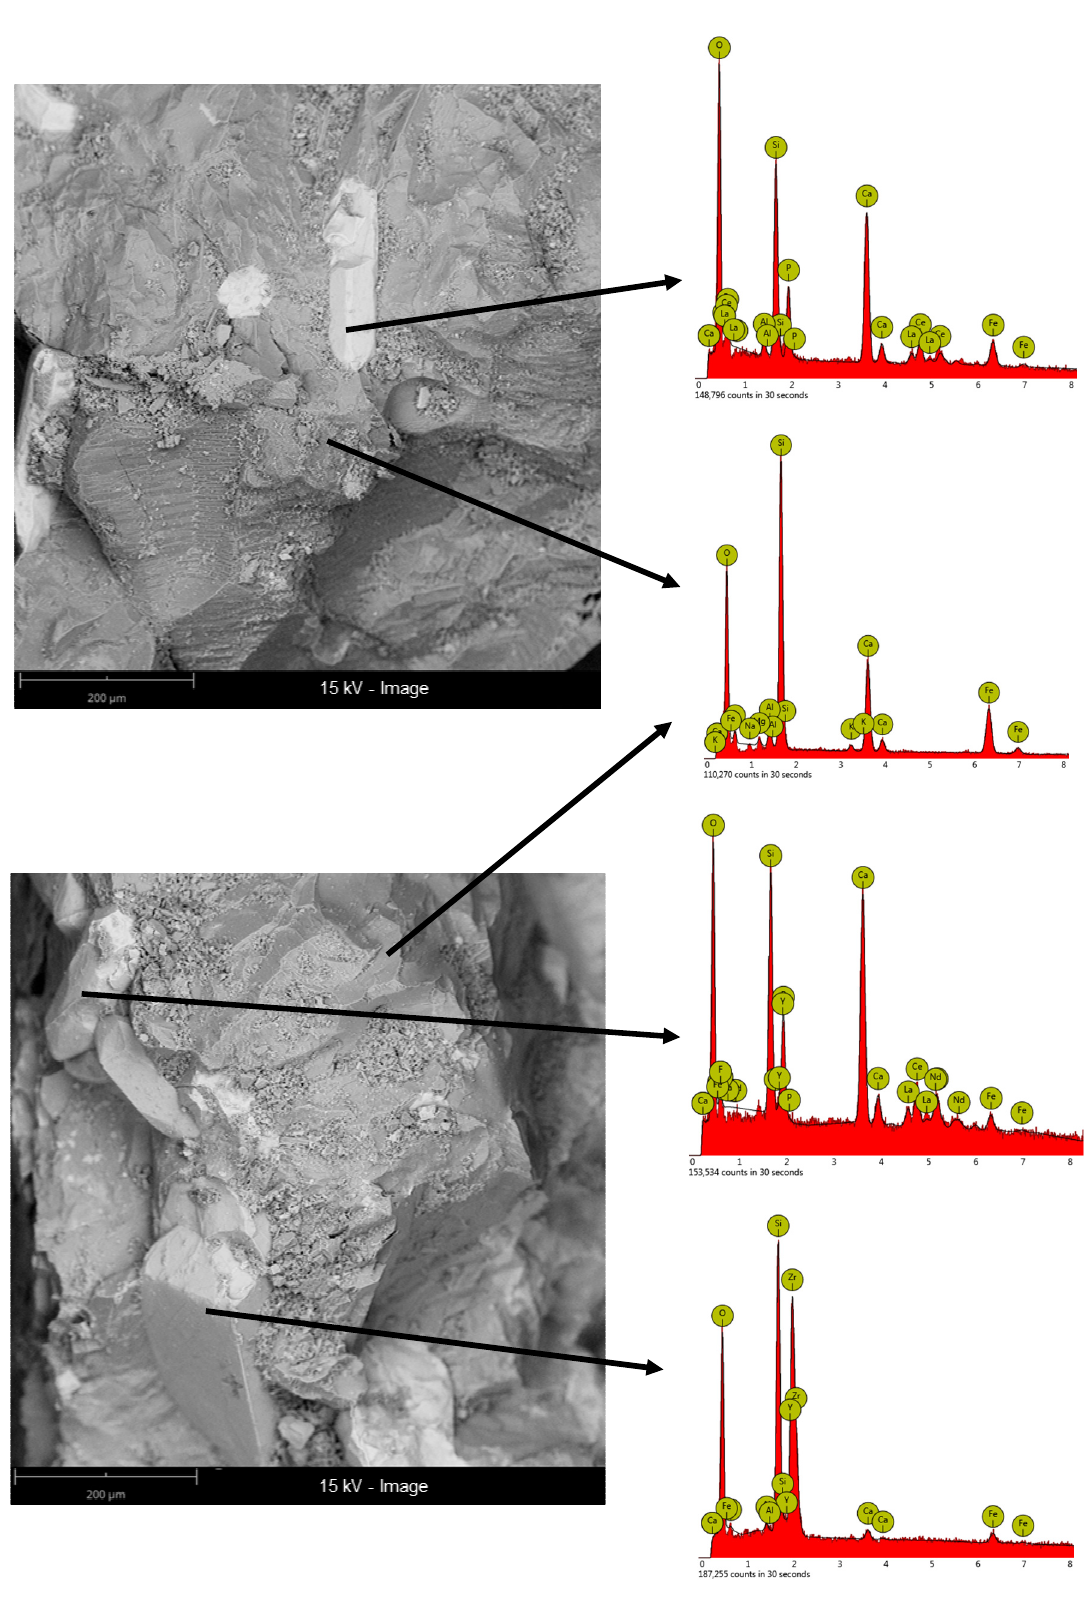
Figure 2. Image of the backscattered electrons of the ore and EDS spectra of the particles.